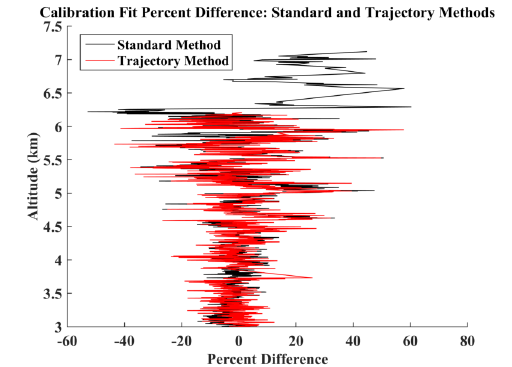
Figure 3: The percent difference between the RS92 mixing ratio profile and lidar calibrated profile using both the standard (black) and trajectory (red)